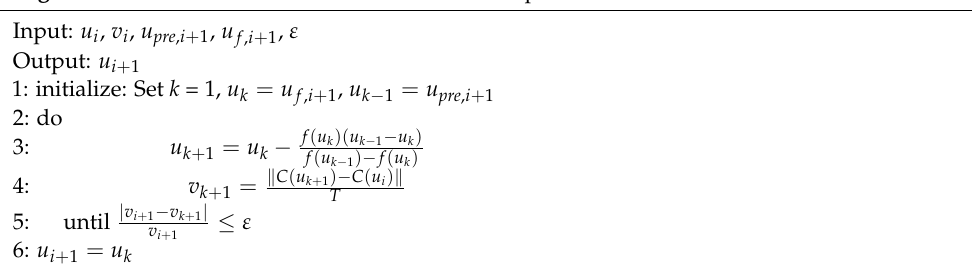
Algorithm 1. Secant-Method Based Parameter